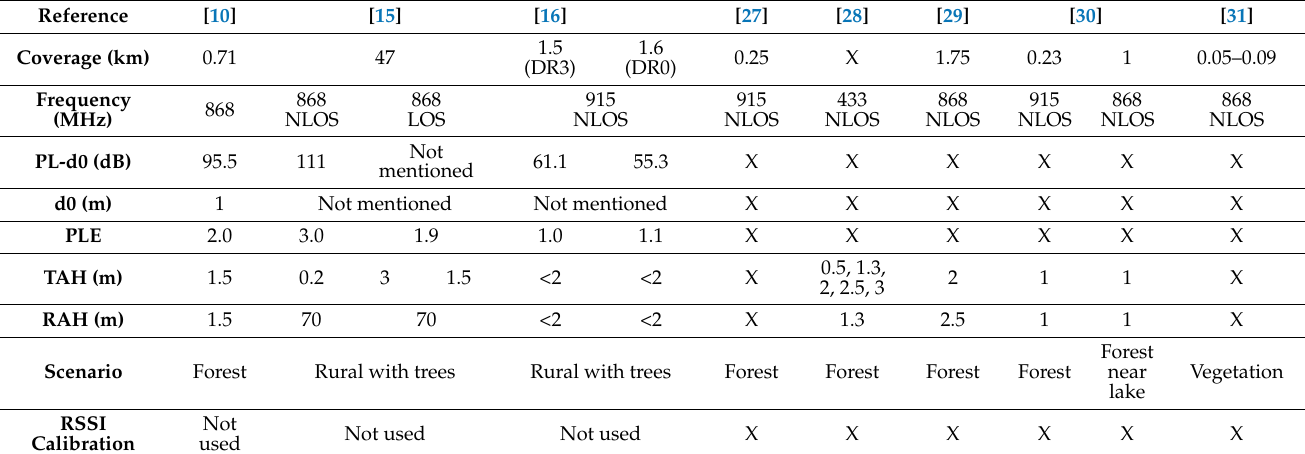
Table 2. Comparison of propagation studies of the LoRa technology in vegetated